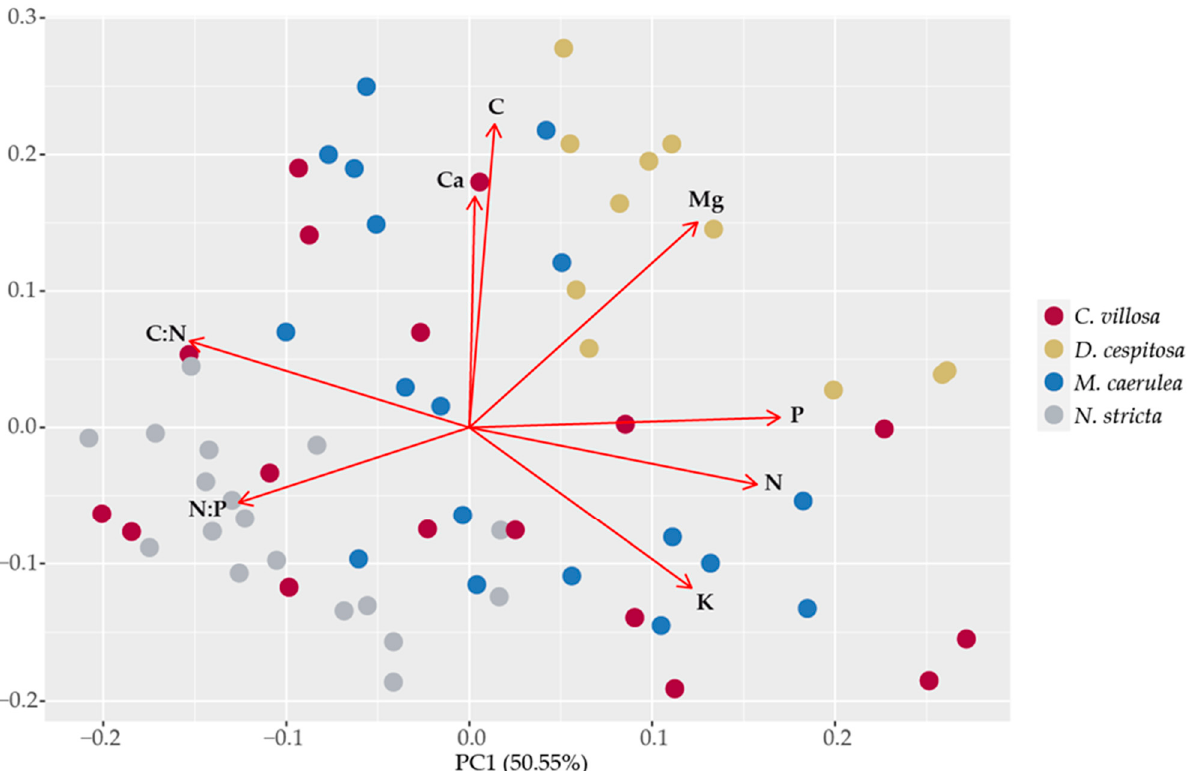
Figure 9. Principal component analysis of the leaf element composition. The points correspond to sample scores and are color-coded by species: Calamagrostis villosa (red dots), Deschampsia cespitosa (yellow dots), Molinia caerulea (blue dots), and Nardus stricta (grey dots). Red arrows correspond to PCA loadings for individual PheCs. Data from all vegetative seasons in 2020 were included in the analysis.